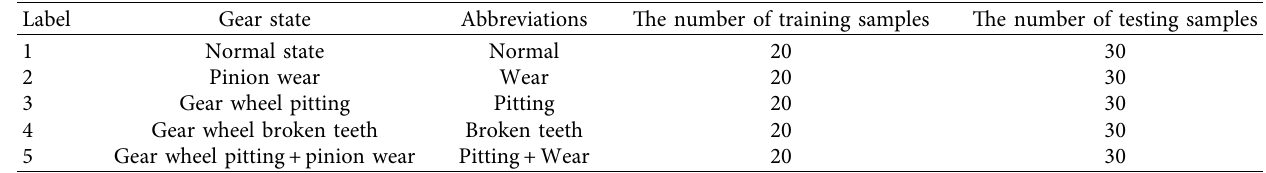
Table 5: Detailed information of different working states of